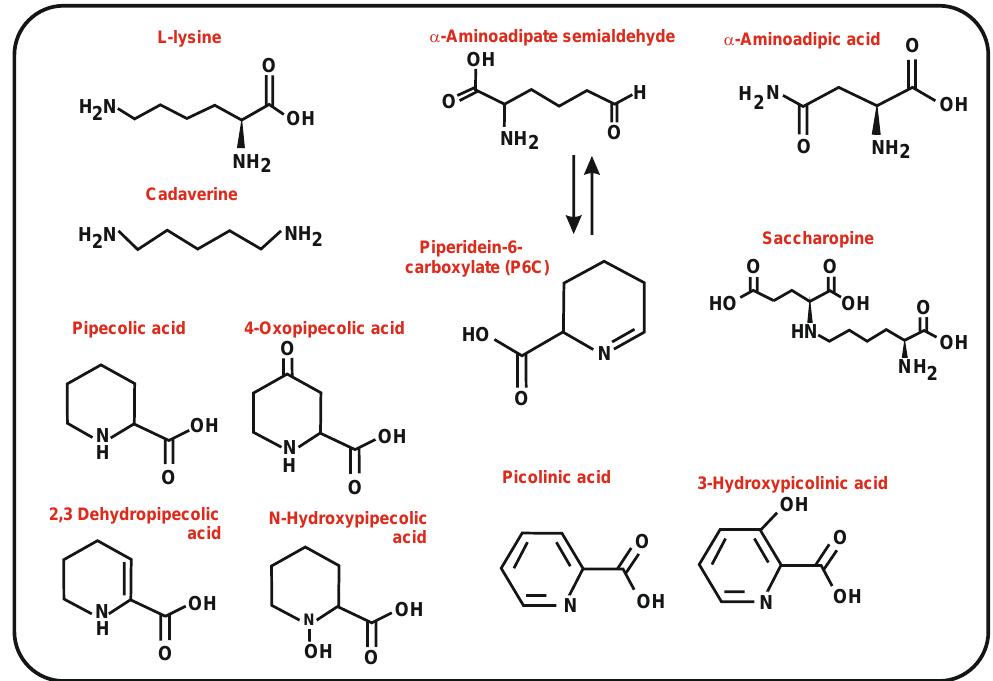
Figure 2. Chemical structure of intermediates of the lysine biosynthesis pathway (lysine, saccharopine, α -Aminoadipate semialdehyde, Piperideine-6-Carboxilic acid, and α -Aminoadipic acid) or compounds derived from lysine (pipecolic acid, 4-Oxo-pipecolic acid, 2-3 Dehydropipecolic acid, N-hydroxypipecolic acid, and 3 Hydroxypicolinic acid) that are precursors of secondary metabolites. The interconversion of α -aminoadipate semialdehyde in P6C is shown by a double arrow.